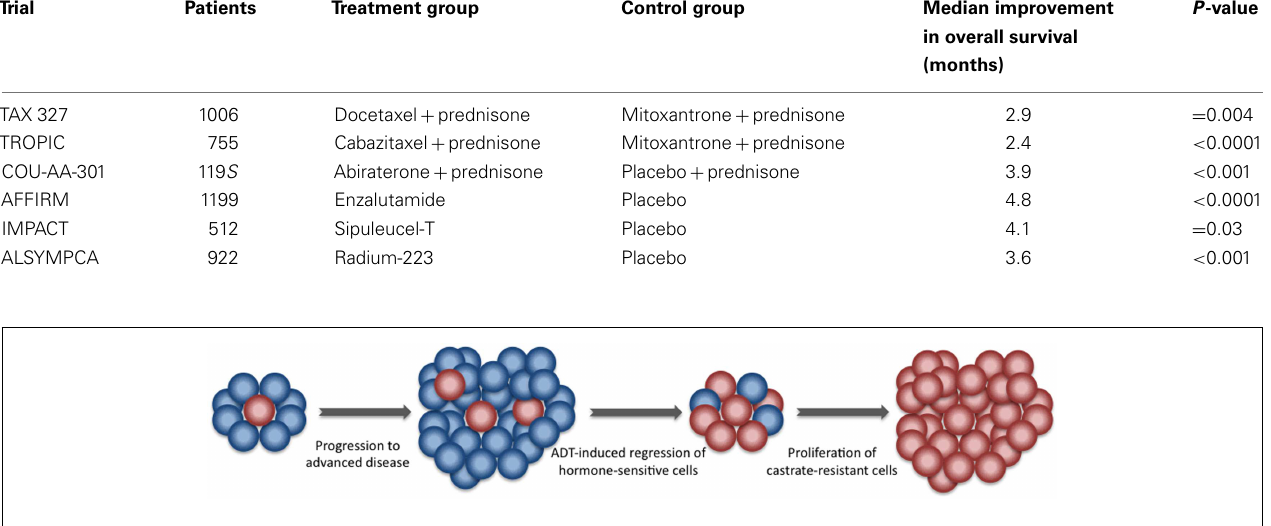
FIGURE 3 | Development of castrate-resistant prostate cancer . Newly diagnosed prostate cancer is composed of a group of heterogeneous cells. The majority is hormone-sensitive. A minority are